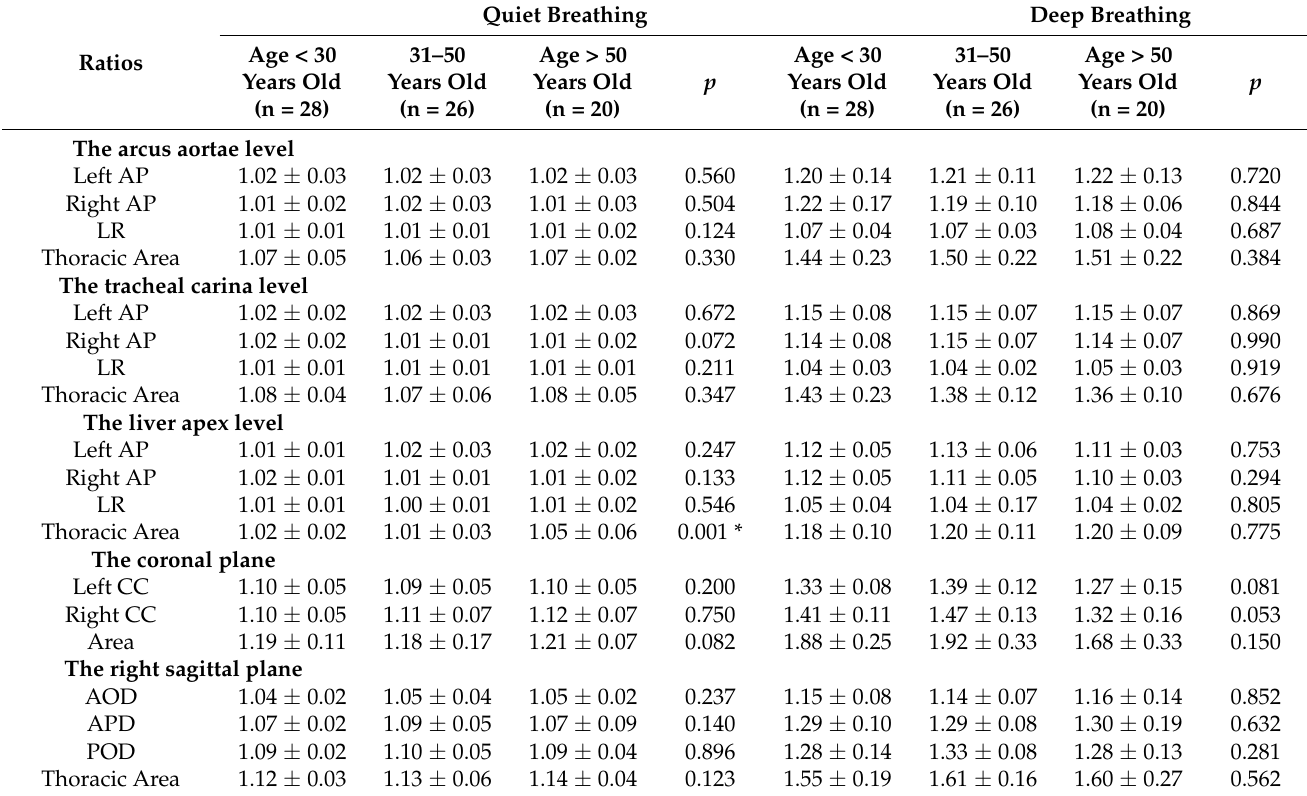
Table 2. The correlation of chest wall and diaphragmatic motion with age.